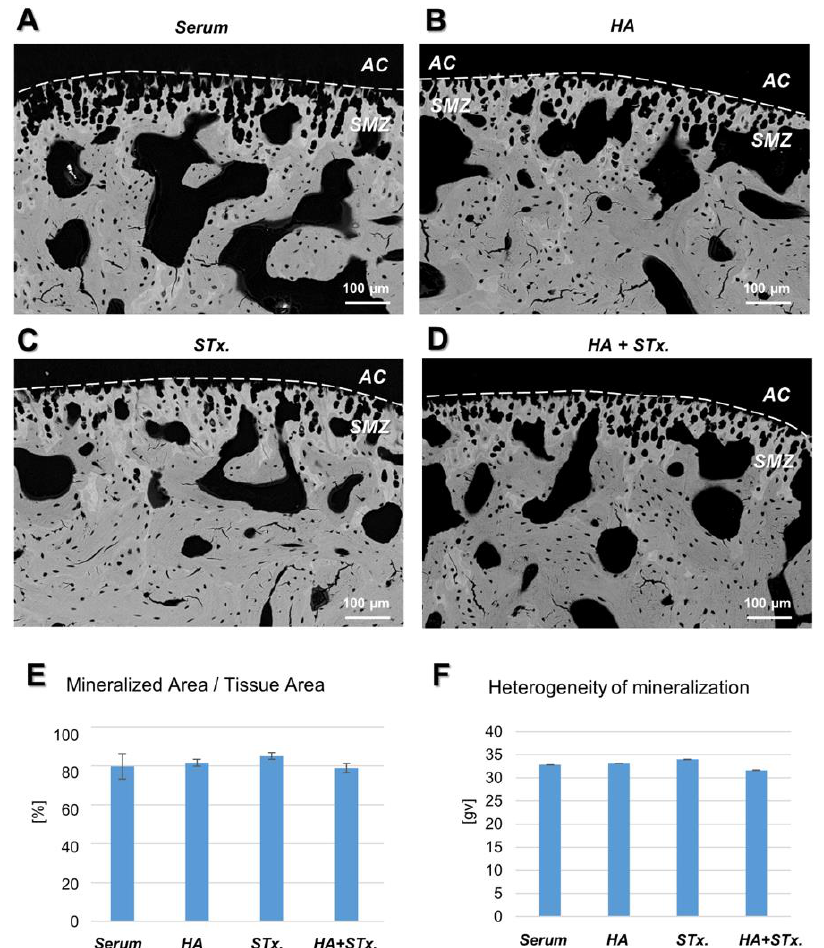
Figure 4. Representative back-scattered images of temporomandibular joint (TMJ) specimens of all groups. ( A – D ) The images show a cross-sectional view of the TMJ, whereby darker pixels correspond to a low degree of mineralization and brighter pixels correspond to higher degree of mineralization. The articular cartilage (AC) is located on top of the subchondral mineralized zone (SMZ) which is composed of calcified cartilage containing chondrocyte lacunae and subchondral bone containing osteocyte lacunae. ( E ) In the calcified cartilage zone, the ratio of mineralized area per tissue area, an inverse measure of tissue porosity, was similar between the groups. ( F ) The heterogeneity of mineralization, assessed as the full-width-half-maximum of the gray value histogram, was similar between groups.